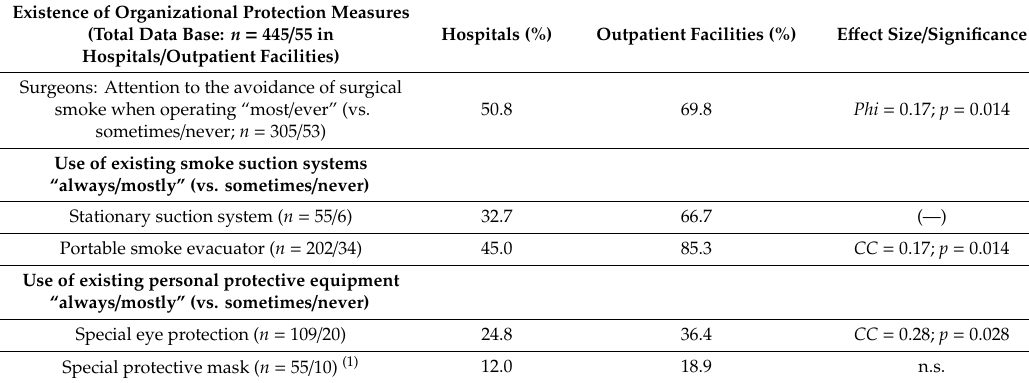
Table 4. Use of protective measures in